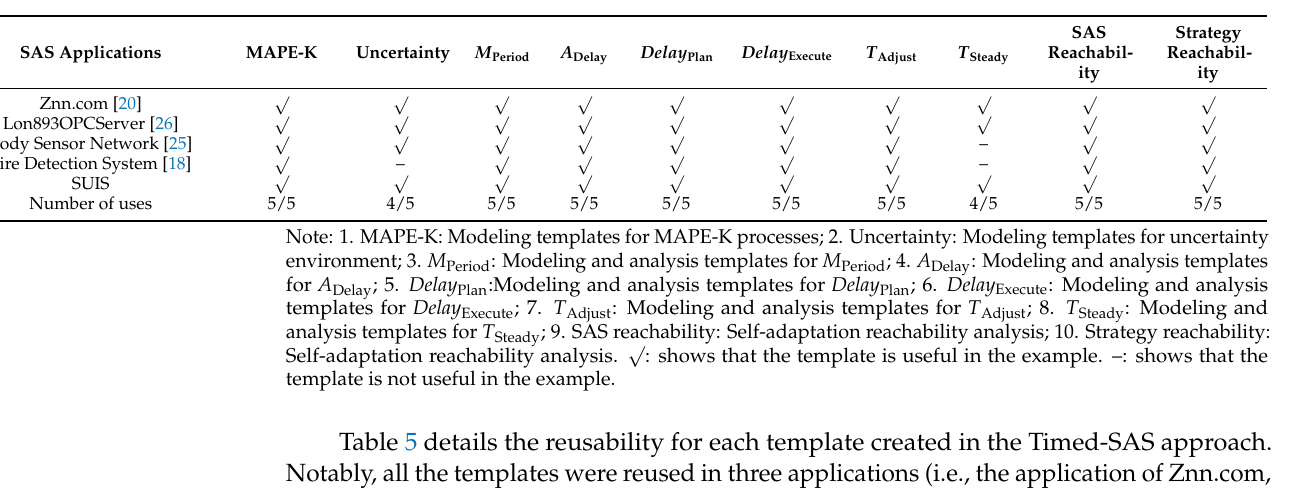
Table 5 details the reusability for each template created in the Timed-SAS